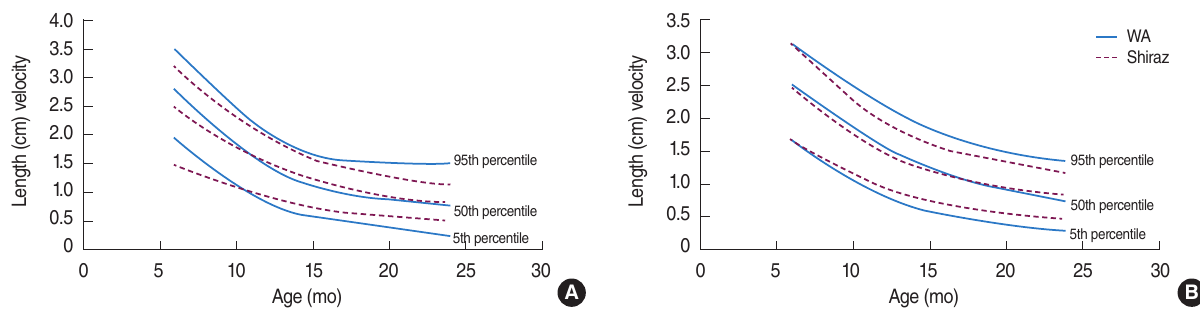
Figure 3. Length (cm) velocity of infants in West Azerbaijan (WA) and Shiraz, Iran. (A) Males and (B) females. Table 2. Comparison of 50th percentile (median) of length and weight velocities of West Azerbaijan (WA) Shiraz, and UK infants, by sex and age Length velocity (cm/yr) Weight velocity (kg/yr) Males Females Males Females WA